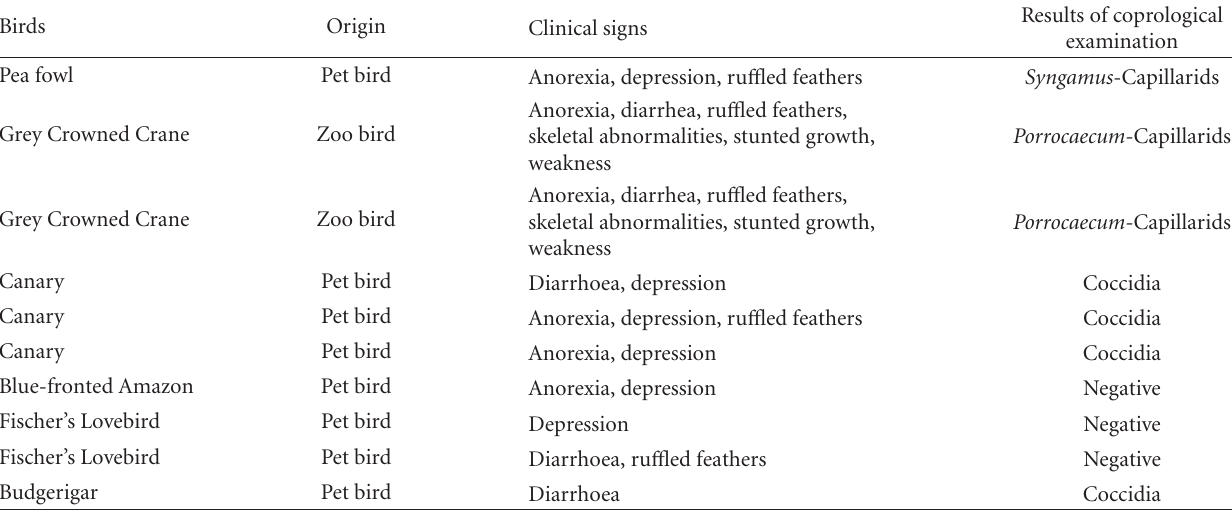
Table 4: Clinical signs and results of coprological examination in symptomatic pet and zoo birds ( n = 10).